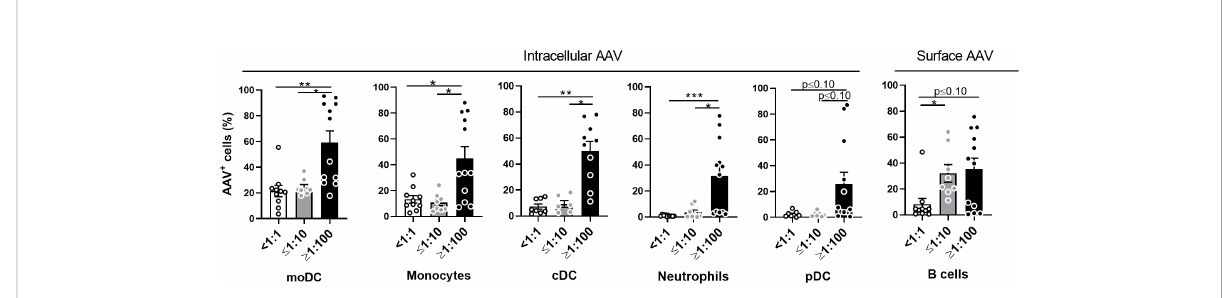
FIGURE 3 AAV NAbs enhance uptake of AAV vector into blood phagocytes. Whole blood from healthy human donors was stimulated with AAV-LK03 at 5×10 11 vg/mL for 24 hours and stained for intracellular AAV and phenotypic markers. Samples were categorized based on their titers of anti- AAV-LK03 neutralizing antibodies as indicated under x axis. Graphs show percentage of AAV + cells within the indicated cell subtype. Figure 1C shows data from the same set of samples. Bars represent the mean ± SEM and symbols represent the individual values of blood samples. Signi fi cance was determined by the Kruskal-Wallis test with Dunn ’ s multiple comparisons test. *p ≤ 0.05; ** p ≤ 0.01; *** p ≤ 0.001;.